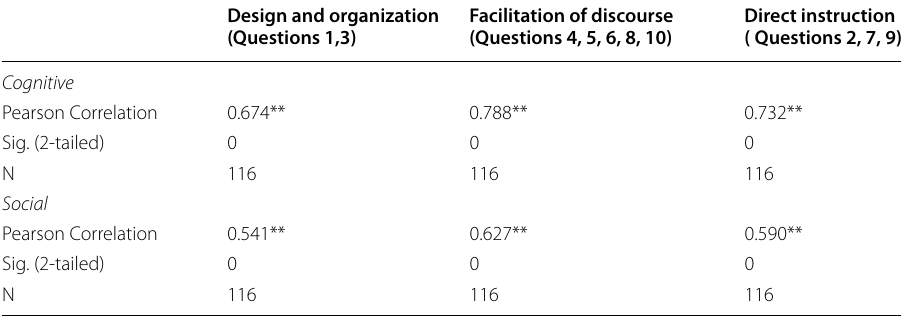
Table 4 Correlations between three components of teaching presence and cognitive, social presence